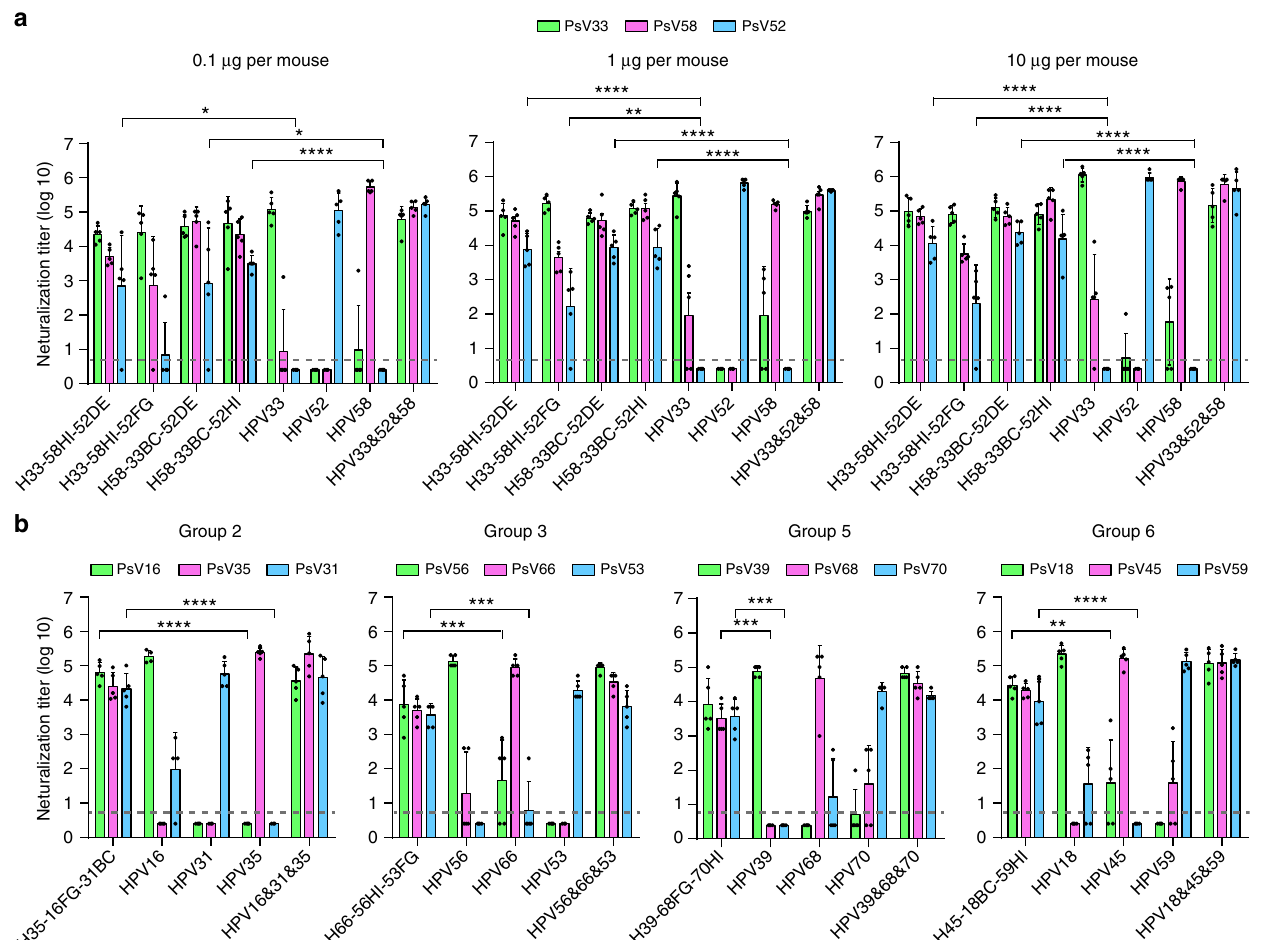
Fig. 5 Immunogenicity of loop-swapped HPV33/58/52 chimeric VLPs at three dosages and other triple-type chimeric VLPs. a Groups of mice ( n = 5) were immunized with 0.1, 1 or 10 μ g per dose of selected chimeric or WT VLPs at weeks 0, 2 and 4. Immune sera were collected at week 8 and analyzed by neutralization assays. b Neutralization titers of immune sera (at week 8) in BALB/c mice ( n = 5) immunized with 5 μ g per dose of chimeric and WT L1 proteins of Groups 2, -3, -5, and -6 (also see Fig. 1a) in aluminum adjuvant at weeks 0, 2 and 4. All the data were analyzed by one-way ANOVA, ** P < 0.01; *** P < 0.001; **** P < 0.0001. The error bars are standard deviation and symbols represent individual mice. The dotted line indicates the limit of detection for the assay. Non-neutralizing sera were assigned a value of one-half of the limit of detection for